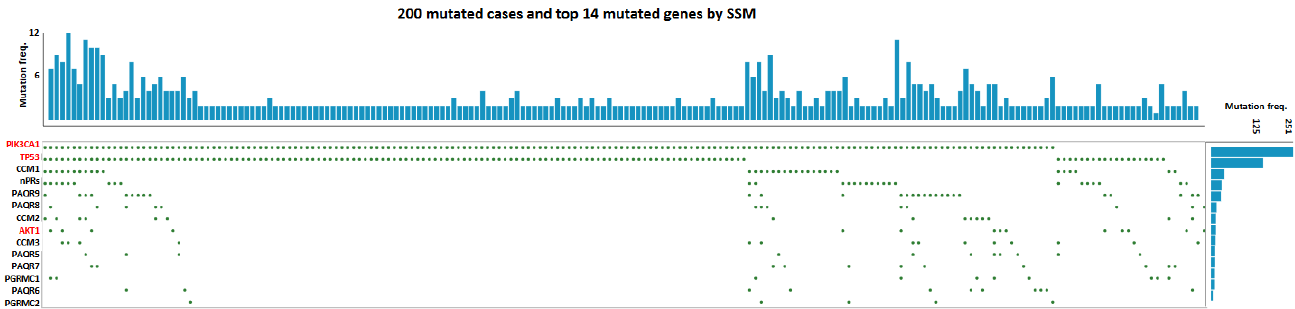
Figure 2. Oncogrid analysis of simple somatic mutations in known reproductive cancer oncogenes and key genes within the CmPn signaling network. Known driver oncogenes (red colored) and key components (black colored) of the CmPn signaling network from 200 breast cancer lesions in Genomic Data Commons (GDC) and The Cancer Genome Atlas ( TCGA ). Utilizing the GDC data portal from the National Cancer Institute (NCI), the distribution of simple somatic mutations (SSM) for reproductive cancer lesions for common cancer driver genes, along with SSM counted in all key CmPn players were assessed. SSM, represented with green dots, are somatic mutations that include single base substitutions, small deletions, and insertions ( ≤ 200